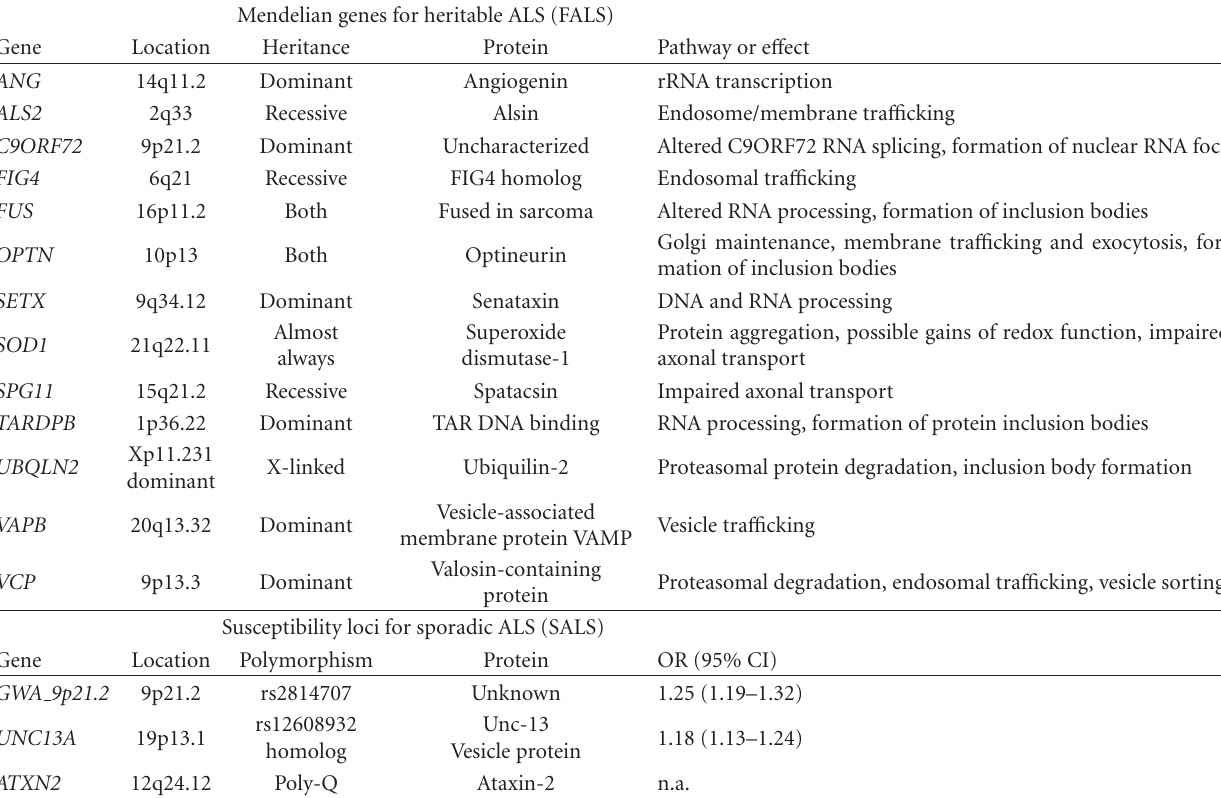
Table 1: Mendelian and non-Mendelian loci known to cause FALS or confer risk for SALS. Polymorphisms in the VEGF promoter that were originally associated with increased ALS risk have not been confirmed in subsequent studies but may act as modifiers of disease onset or progression in subsets of ALS cases